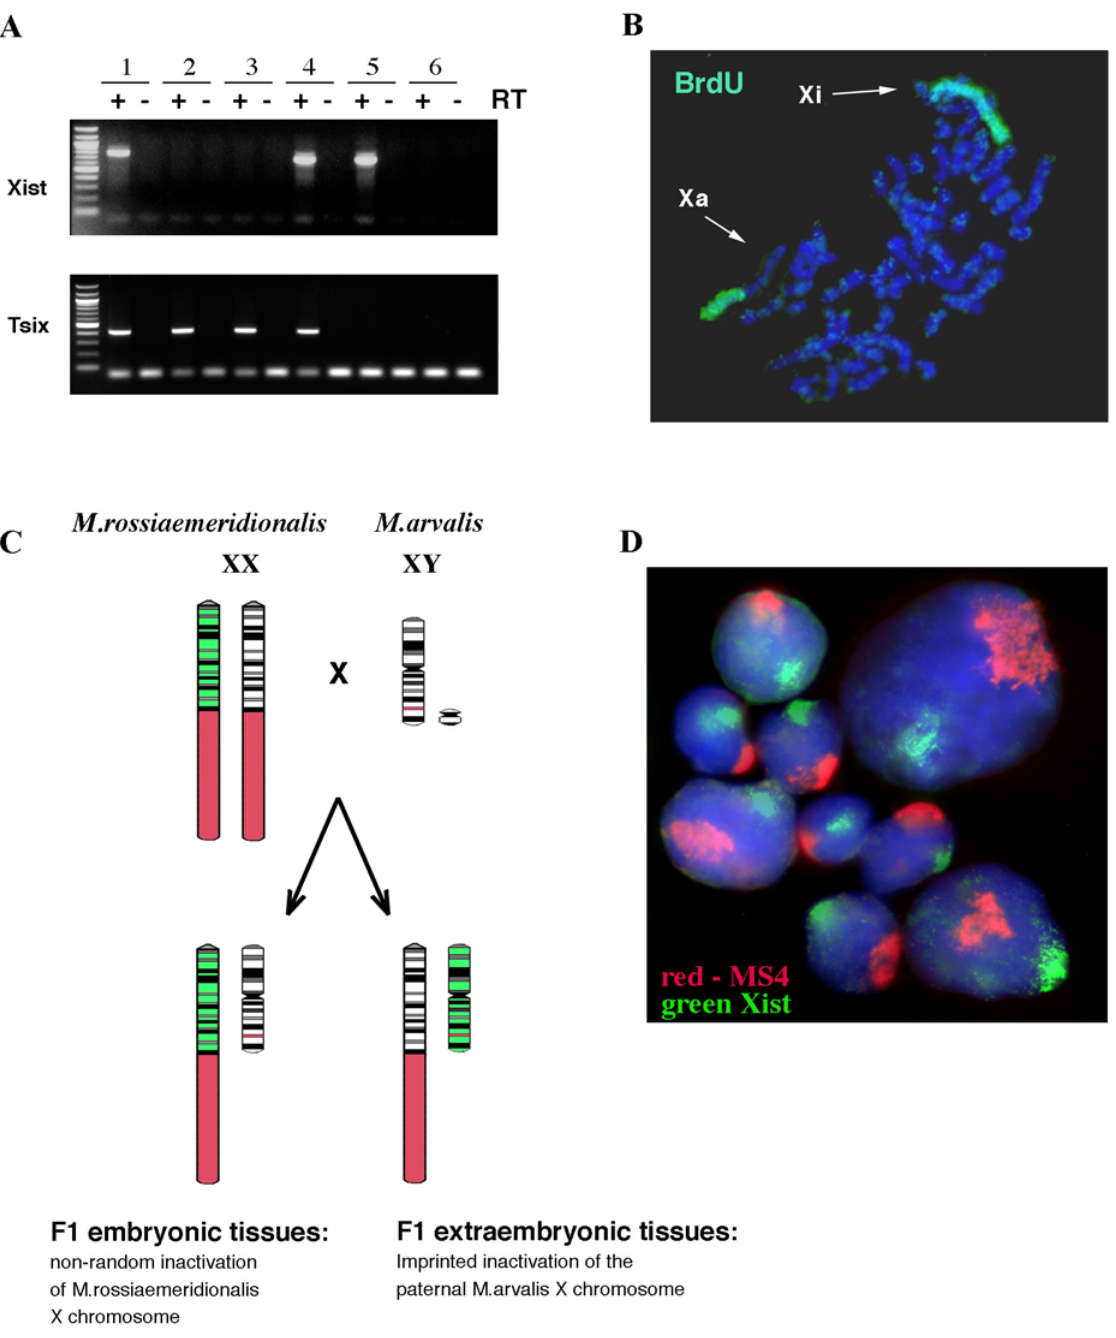
Figure 5. Imprinted inactivation of the X chromosome in vole TS-like cells. ( A ) RT-PCR analysis of Xist and Tsix expression in vole TS-like cells: vole placenta (1); X0 undifferentiated (2) and differentiated cells (3); XX undifferentiated (4) and differentiated cells (5); mouse feeders (6). ( B ) M. rossiaemeridionalis XX TS-like cells exhibit late replication of one of the X chromosomes, as detected by a FITC-coupled anti-BrdU antibody (green). Note that the entire inactive chromosome (Xi) is stained, while only the constitutive heterochromatin region is stained on the active (Xa) chromosome. Chromosomes are counterstained with DAPI. ( C ) Schematic showing the pattern of X chromosome inactivation in embryonic and extraembryonic tissues of M. rossiaemeridionalis x M. arvalis vole hybrids. Xist RNA on the inactive X chromosome (green), the M. rossiaemeridionalis heterochromatin block (red). ( D ) RNA-DNA FISH analysis of the X inactivation pattern in TS-like cells derived from an M. rossiaemeridionalis x M. arvalis hybrid embryo. Xist RNA is detected with FITC (green) and the M. rossiaemeridionalis X chromosome heterochromatin specific repeat MS4, is detected with Texas Red (red).